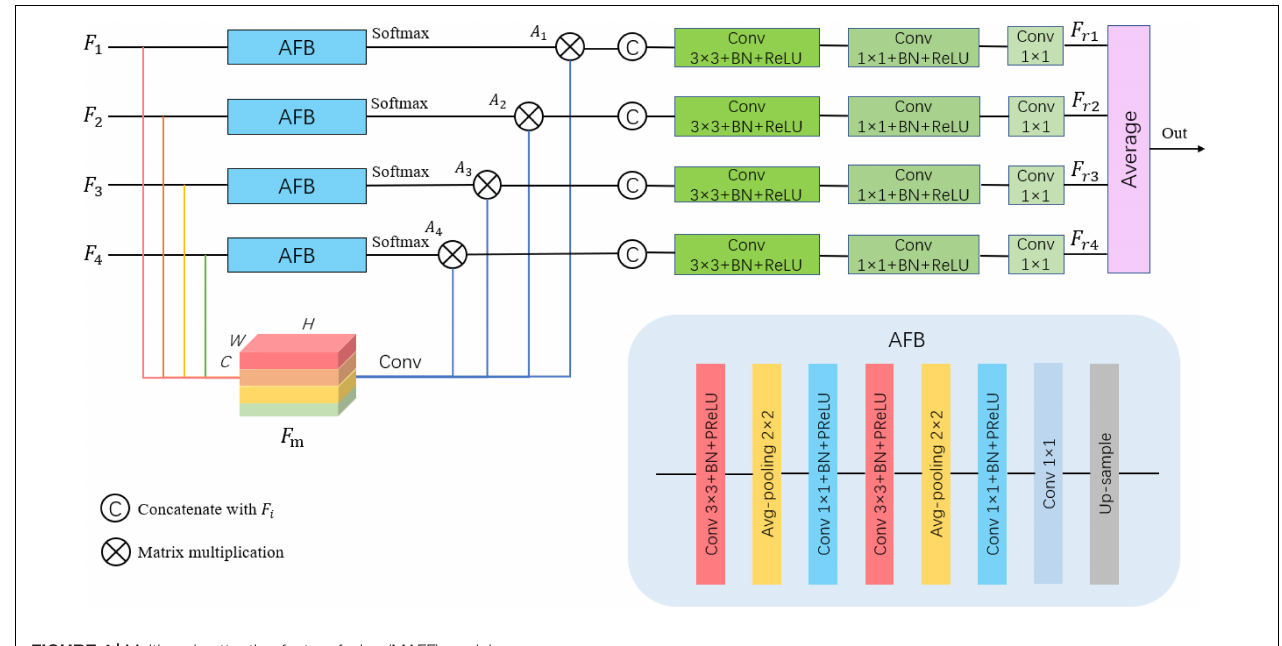
FIGURE 4 | Multi-scale attention feature fusion (MAFF) module. TABLE 1 | Comparison of segmentation results (mean ± SD) between the proposed MAFF-ResUNet and existing deep convolutional neural networks. FCN32s FCN16s FCN8s U-Net MAFF-ResUNet